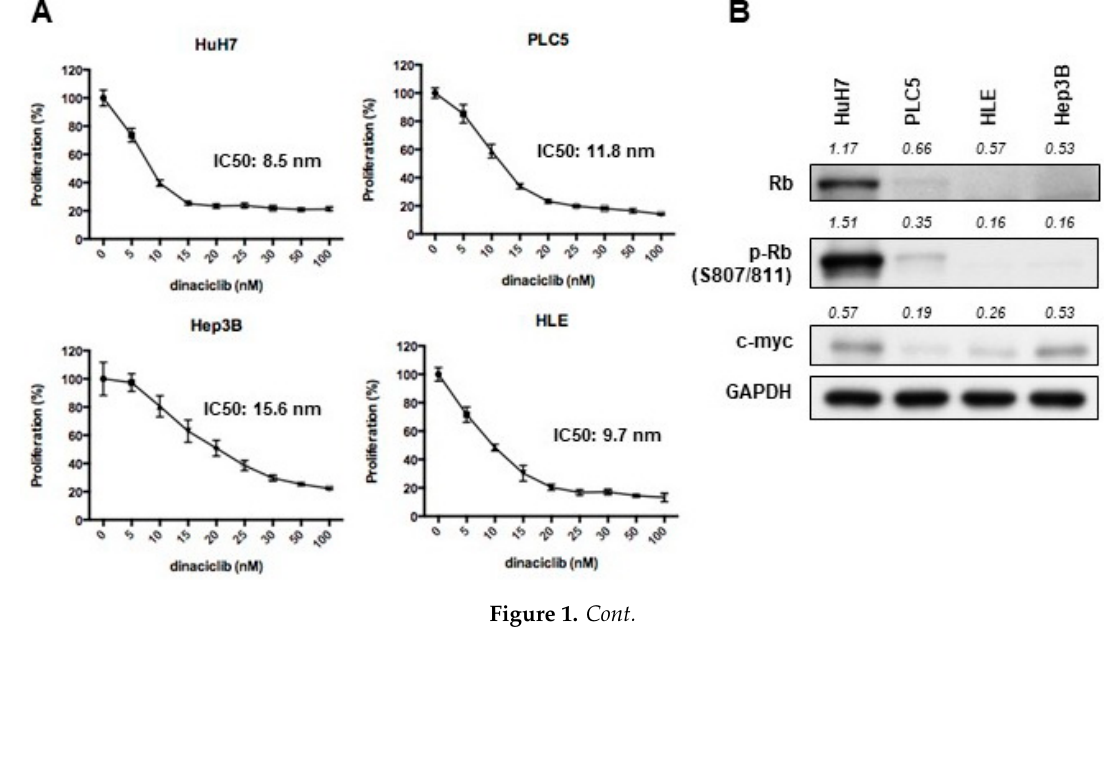
Figure 1. Cont. Figure 1.